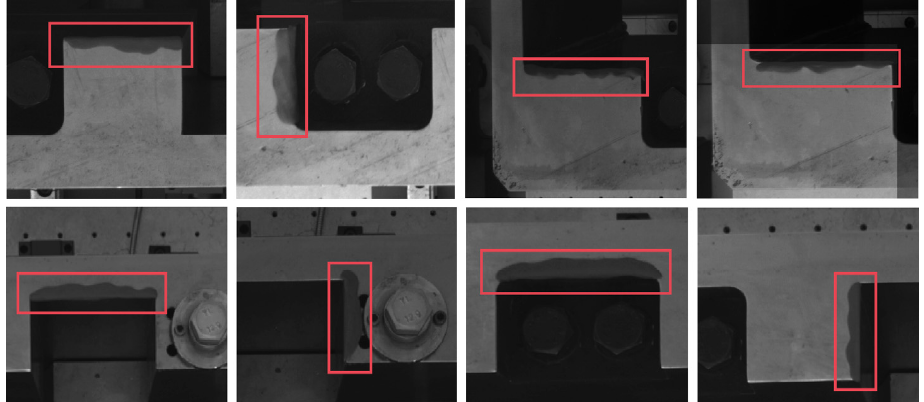
Figure 9. Partial images of the contaminated parts of the cutter holder. The red boxes show the various contamination conditions of the cutter holder.